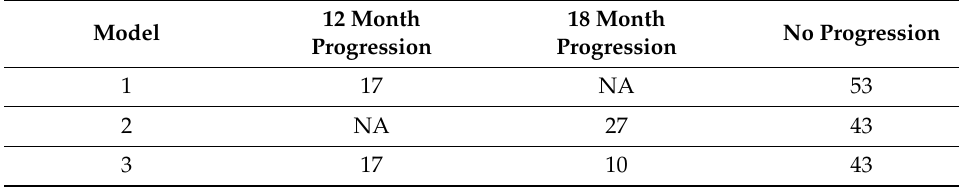
Table A2. The original count of samples for each studied model.